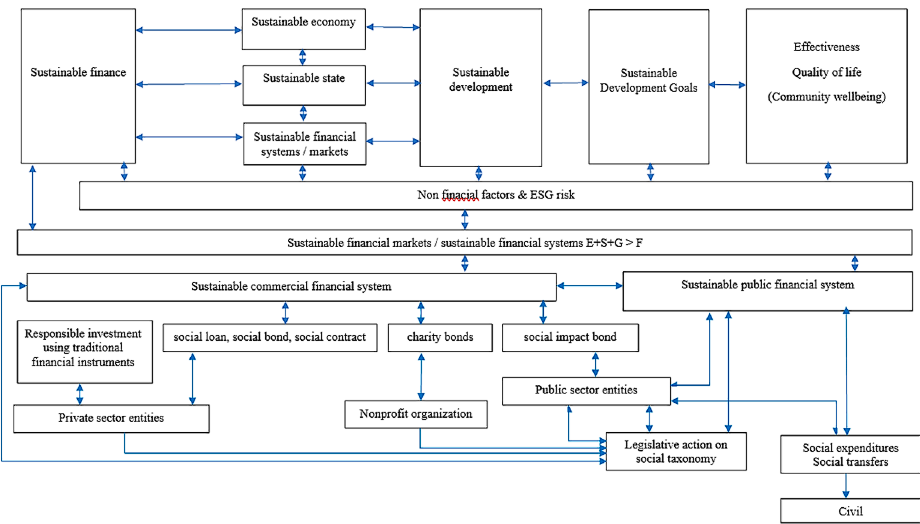
Figure 8. Sustainable finance model for sustainable economy – social